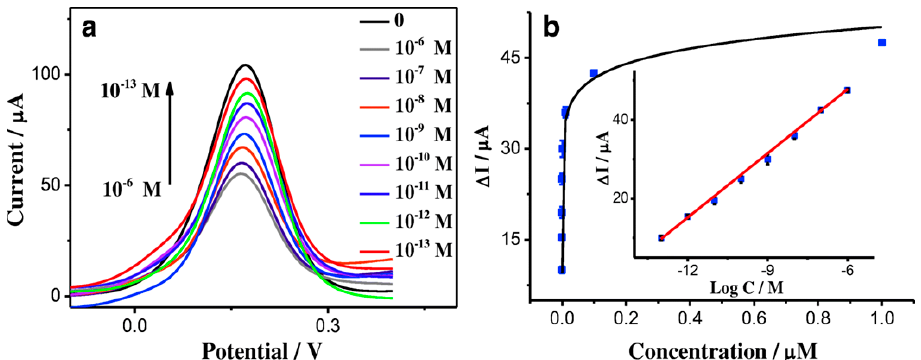
Figure 22. ( a ) Differential pulse voltammetry (DPV) response of the aptasensor to a series of ATP solutions with concentrations from 10 − 13 to 10 − 6 M at a working voltage of 0.18 V vs. SCE. The current response decreases as ATP concentration increases due decreased ionic content at the electrode surface. ( b ) The corresponding response plot and (inset) calibration plot for the aptasensor (R 2 = 0.998) [109]. Reprinted with permission from Springer Microchimica Acta , “A glassy carbon electrode modified with graphene oxide, poly(3,4-ethylenedioxythiophene), an antifouling peptide and an aptamer for ultrasensitive detection of adenosine triphosphate,” Z. Li, J. Yin, C. Gao, L. Sheng, and A. Meng, Vol. 186, Copyright 2019.